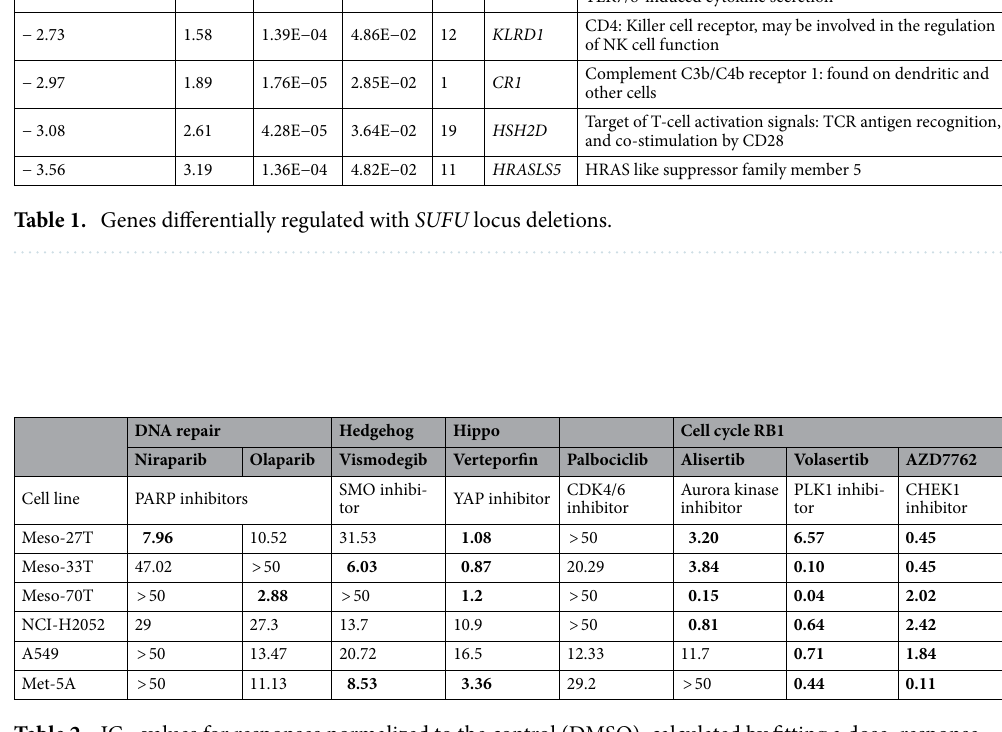
Table 2. IC 50 values for responses normalized to the control (DMSO), calculated by fitting a dose–response curve model in Graph Pad Prism and tabulated as concentration of drugs in µM. In cases where responses were above the highest drug concentration used in the experiment, IC 50 estimates are marked as > 50 µM. Values in bold depict sensitive primary cells and cell lines, where IC 50 to compounds < 10 µM and R 2 (goodness of fit of curve) >